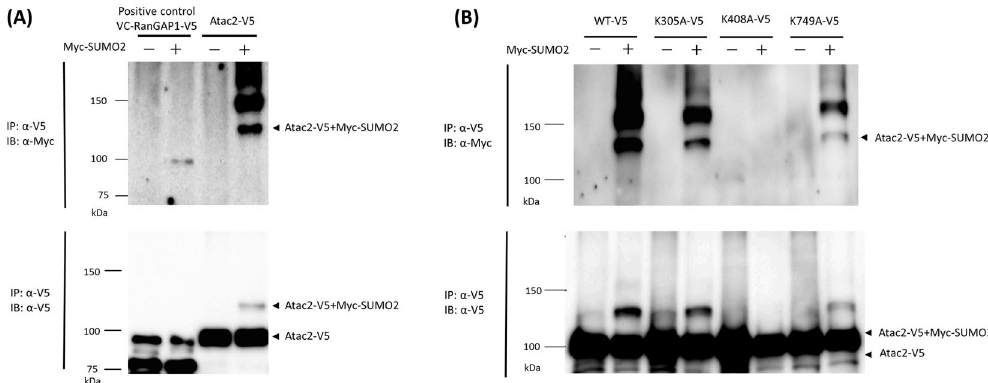
Figure 5. Identification of novel SUMOylated protein Atac2 and its SUMOylation site. ( A ) Atac2 is modified by SUMO2. NIH3T3 cells transfected with the indicated plasmids were subjected to immunoprecipitation with anti-V5 antibodies. The immunoprecipitated proteins were blotted with the indicated antibodies. IP: immunoprecipitation. IB: immunoblotting. The arrowheads show the expected sizes of the indicated proteins. ( B ) SUMO2 binds to K408 in Atac2. NIH3T3 cells expressing the indicated proteins were subjected to immunoprecipitation followed by Western blotting